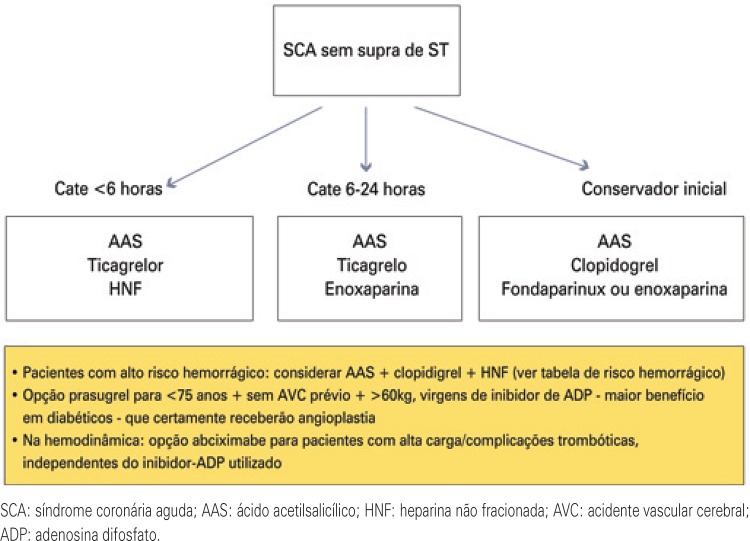
Fluxograma de tratamento antitrombótico conforme estratificação, nas síndrome coronária aguda sem elevação de ST do Hospital Israelita Albert Einstein